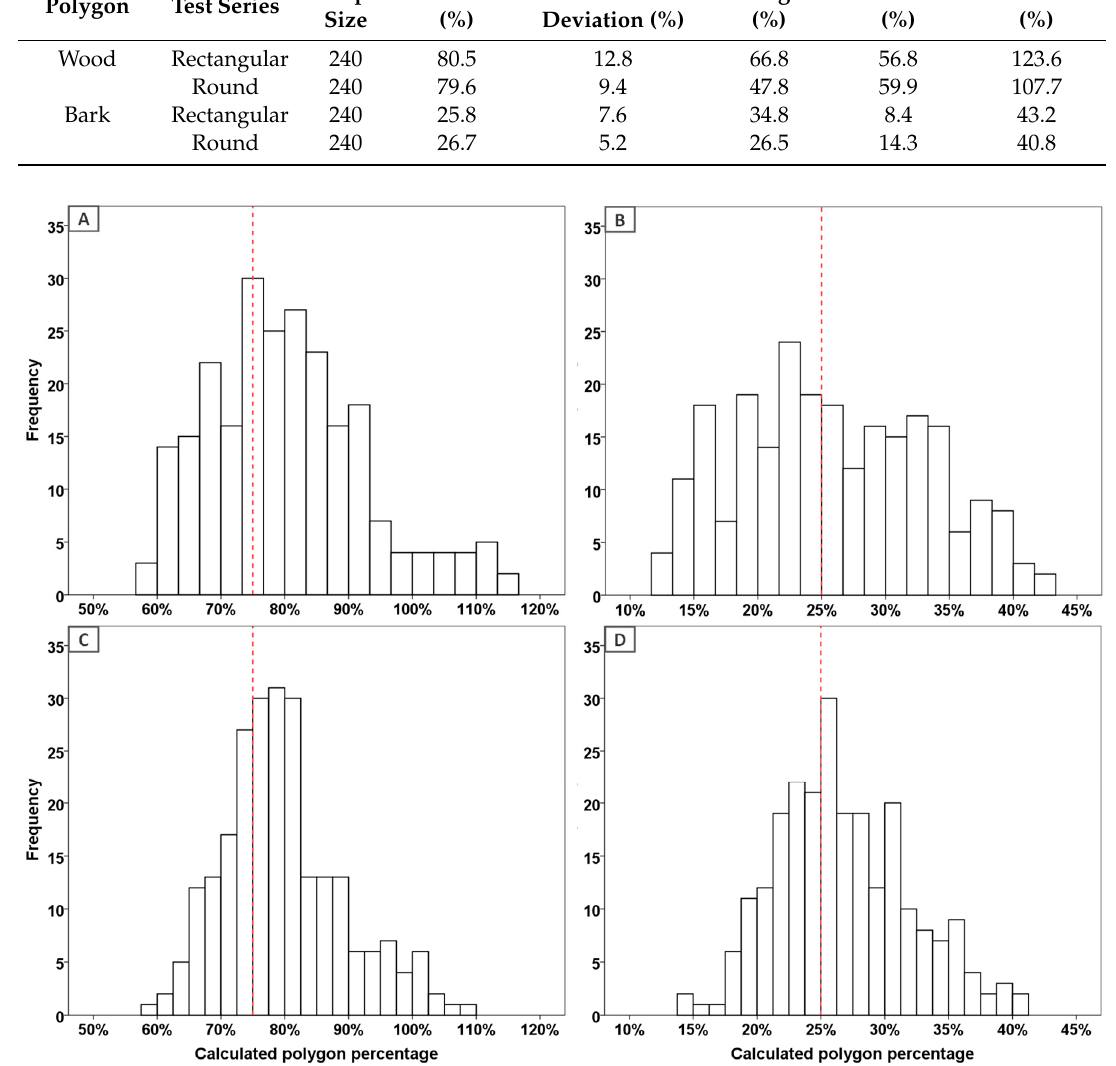
Figure 6. Histograms of measured polygon shares of ( A ) wood surface of the rectangular geometry test series, ( B ) bark surface of the rectangular geometry test series, ( C ) wood surface of the round geometry test series, and ( D ) bark surface of the round geometry test series. The red line identifies the actual share of 75% wood and 25% bark surface.